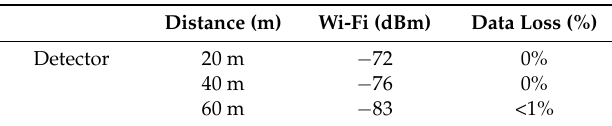
Table 3. Result of the frequency propagation test.